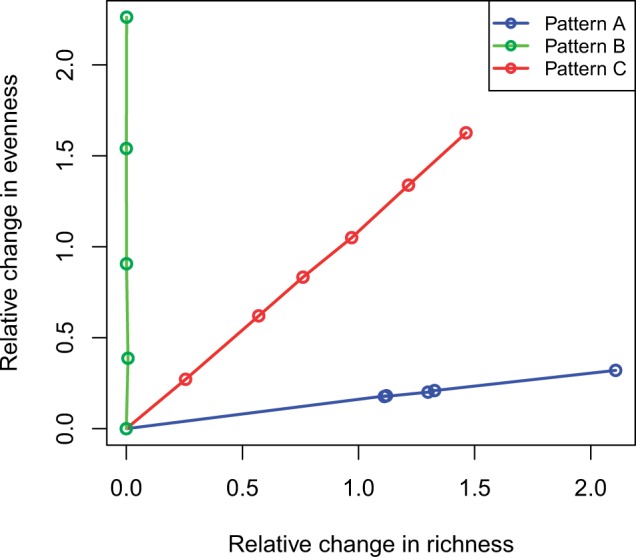
Relative change in richness (total number of present OTUs) and evenness (Shannon’s diversity index) between two groups for the three patterns of differentiation in a random lineage. Each dot represents the effect size we considered in the simulation studies. The plots for the common lineage, rare lineage and random 40 OTUs are similar and not shown